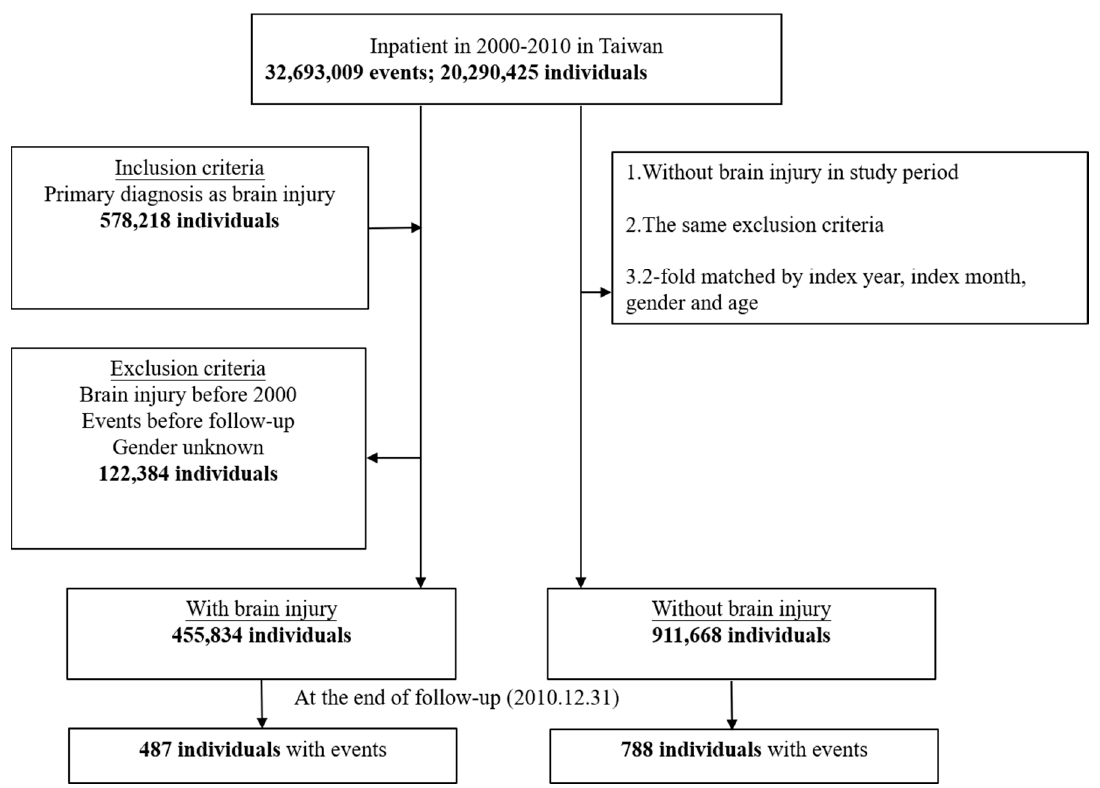
Figure 1. Flowchart of study sample selection from the National Health Insurance Research Database in Taiwan.